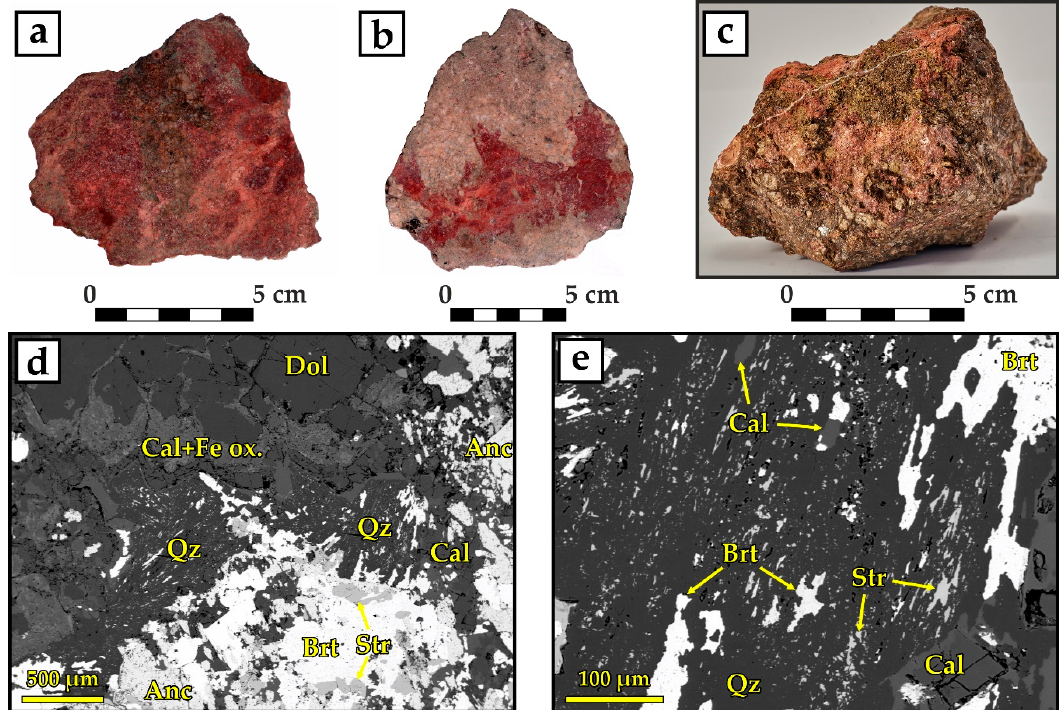
Figure 11. Ancylite assemblage. ( a ) Dissolution cavity in magnesiocarbonatite with minerals of the ancylite assemblage in place of primary dolomite. ( b ) Magnesiocarbonatite (grey) dissected by the vein with minerals of the ancylite assemblage (red). ( c ) Magnesiocarbonatite breccia with a matrix of minerals of the ancylite assemblage. ( d ) Dissolution cavity with intergrowths of strontianite, baryte, and ancylite in the late pore-filling quartz and calcite; dolomite in contact with the dissolution cavity is replaced by calcite with Fe-hydroxide inclusions. ( e ) Quartz-baryte-strontianite intergrowths. Photomicrographs ( d , e ) are BSE images.